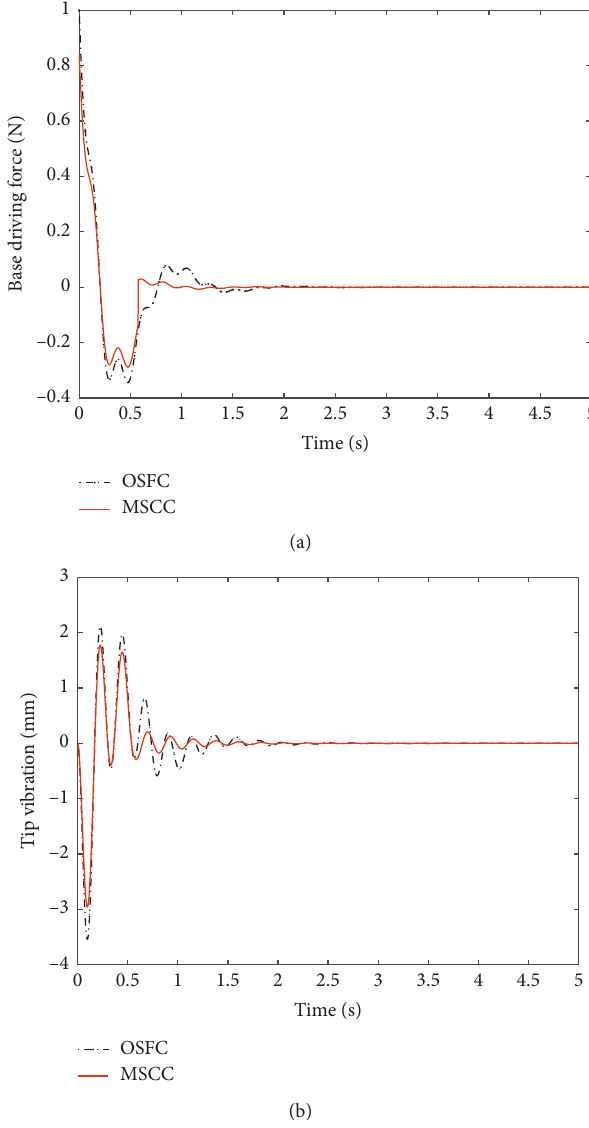
Figure 11: Control effects of the master-slave composite controller and the optimal state feedback controller on the elastic vibration of the MFMS: (a) base driving force and (b) tip